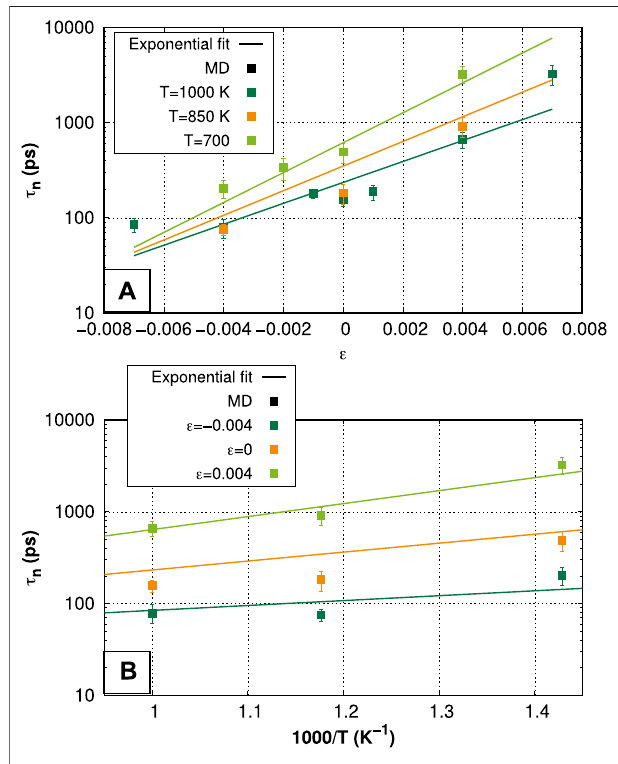
FIGURE 1 | First passage time for a SIA to reach the free surface traveling a distance Δ x (cid:2) 4 . 4 nm as obtained with MD and the theoretical model as a function of (A) applied equibiaxial strain, and (B) inverse